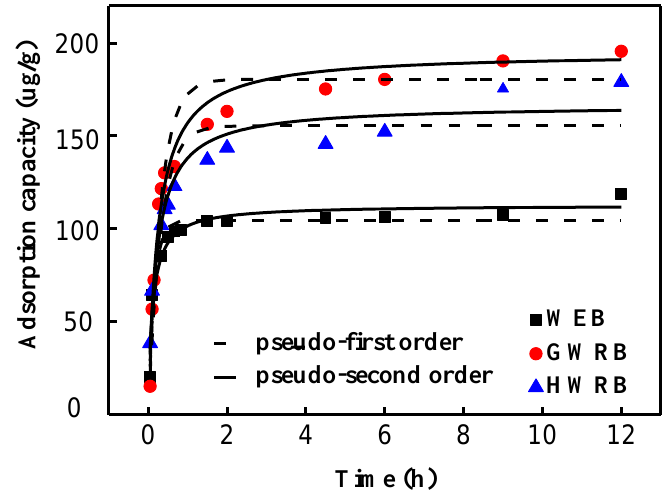
Figure 4. Adsorption kinetics of cimetidine onto WRB, GWRB, and HWRB.